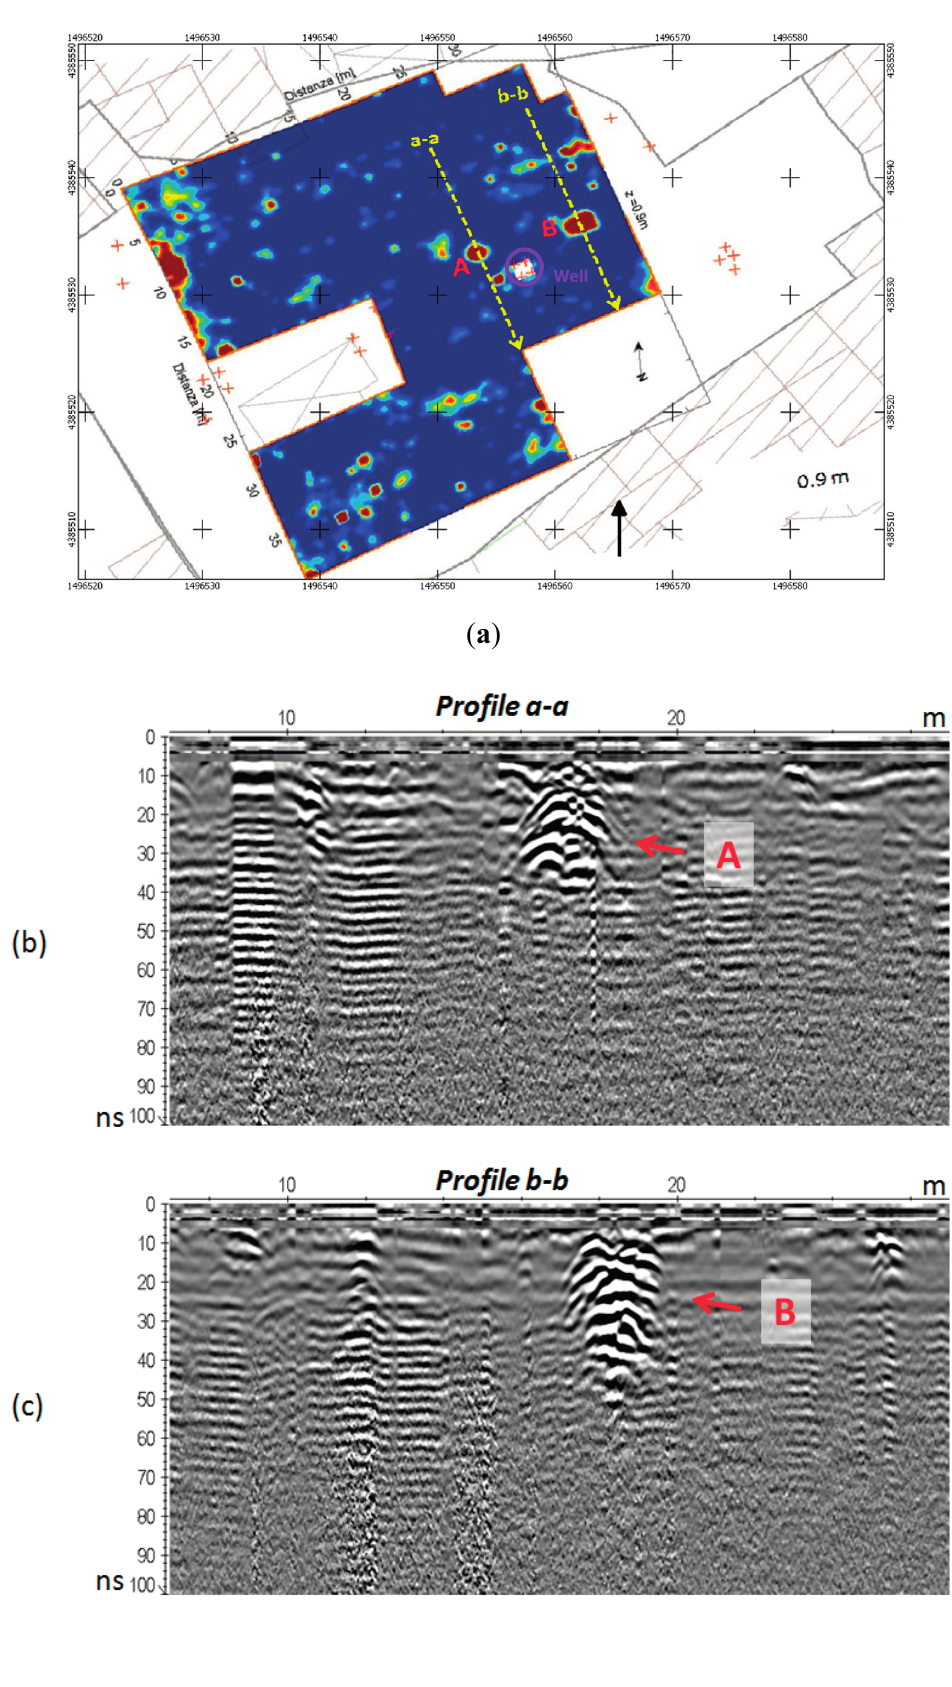
Figure 12. Radargrams crossing the two big anomalies of the GPR map at a 90-cm